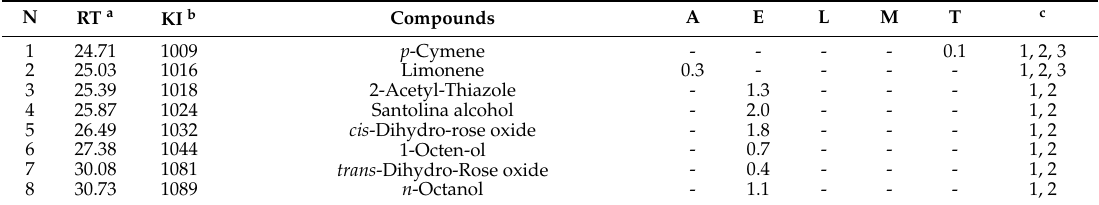
Table 1. Essential oil (EO) compositions (%) of Peganum harmala from Algeria ( A ), Egypt ( E ), Libya ( L ), Morocco ( M ) and Tunisia ( T